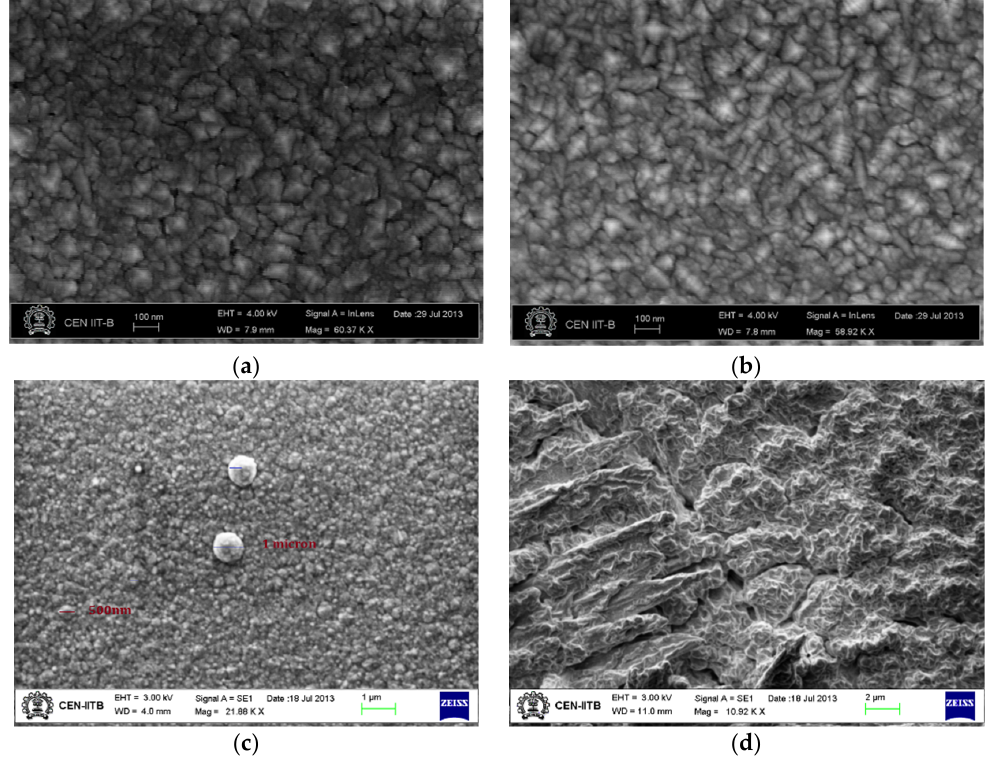
Figure 2. SEM image of boron-doped p-type polycrystalline silicon thick film (Exp. 2) on ( a ) Si/SiO 2 , ( b ) Al 2 O 3 , ( c ) glass/ITO/TiO 2 , and ( d ) Ni-W substrates.